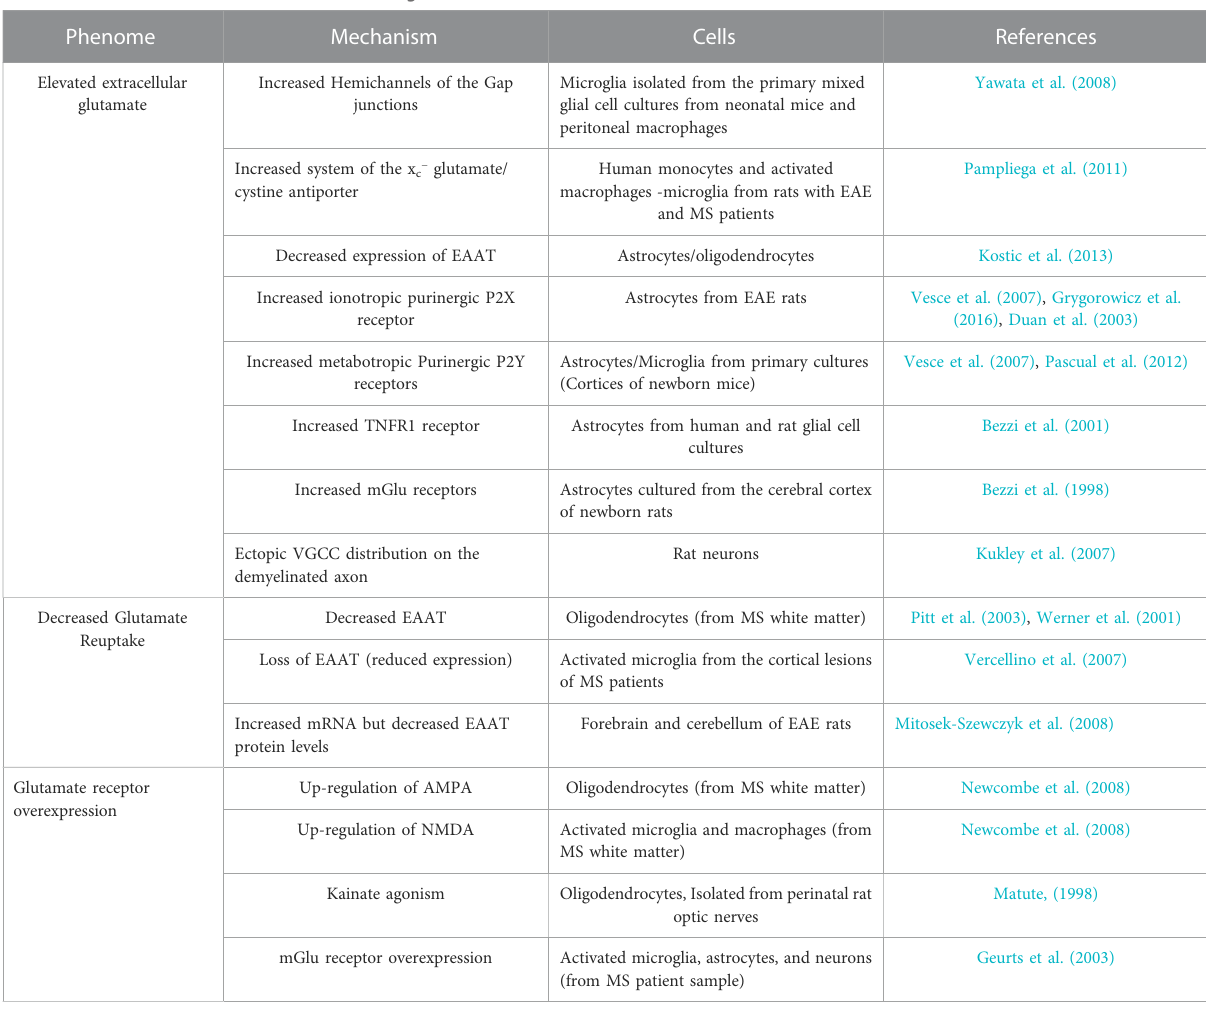
TABLE 1 The main causes of elevated extracellular glutamate in MS or